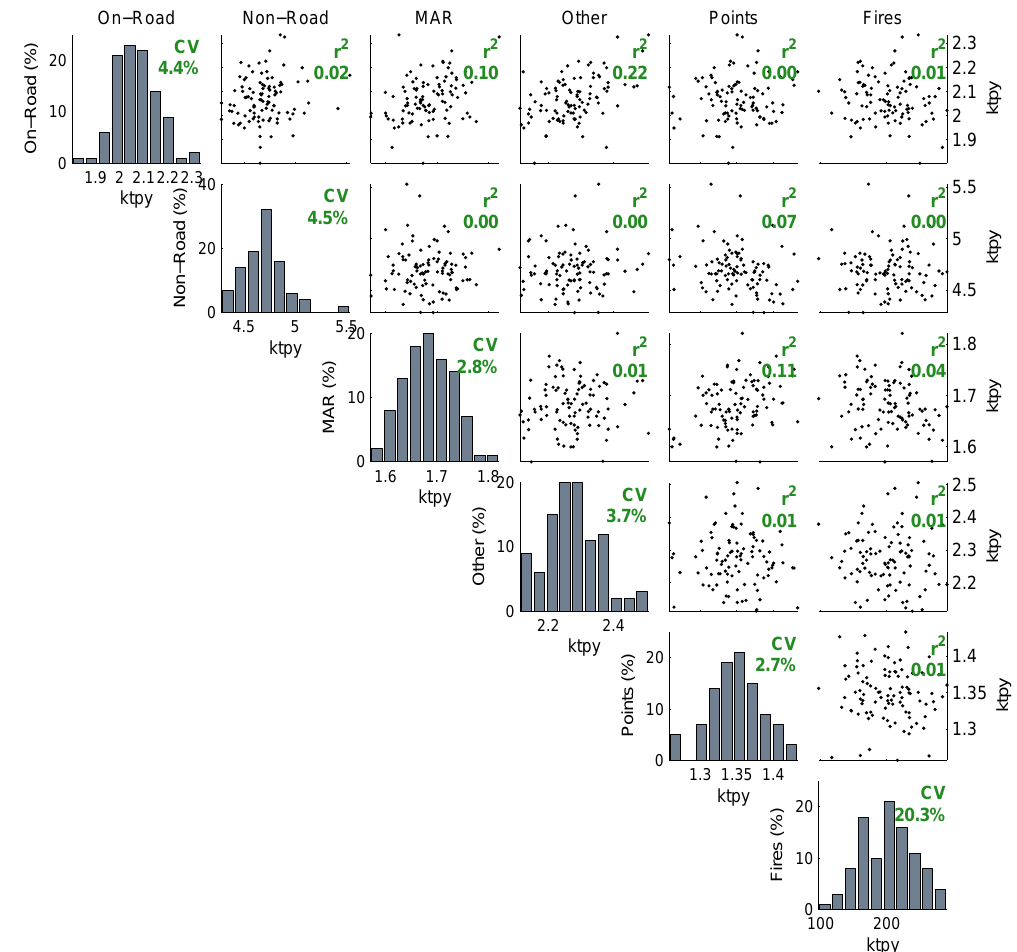
Figure 9. Bootstrapped estimates of uncertainties in inverse EC emissions by source group: histograms show the distribution of emission estimates, scatter plots show the cross-correlation of the estimates. CV = σ/µ is the coefficient of